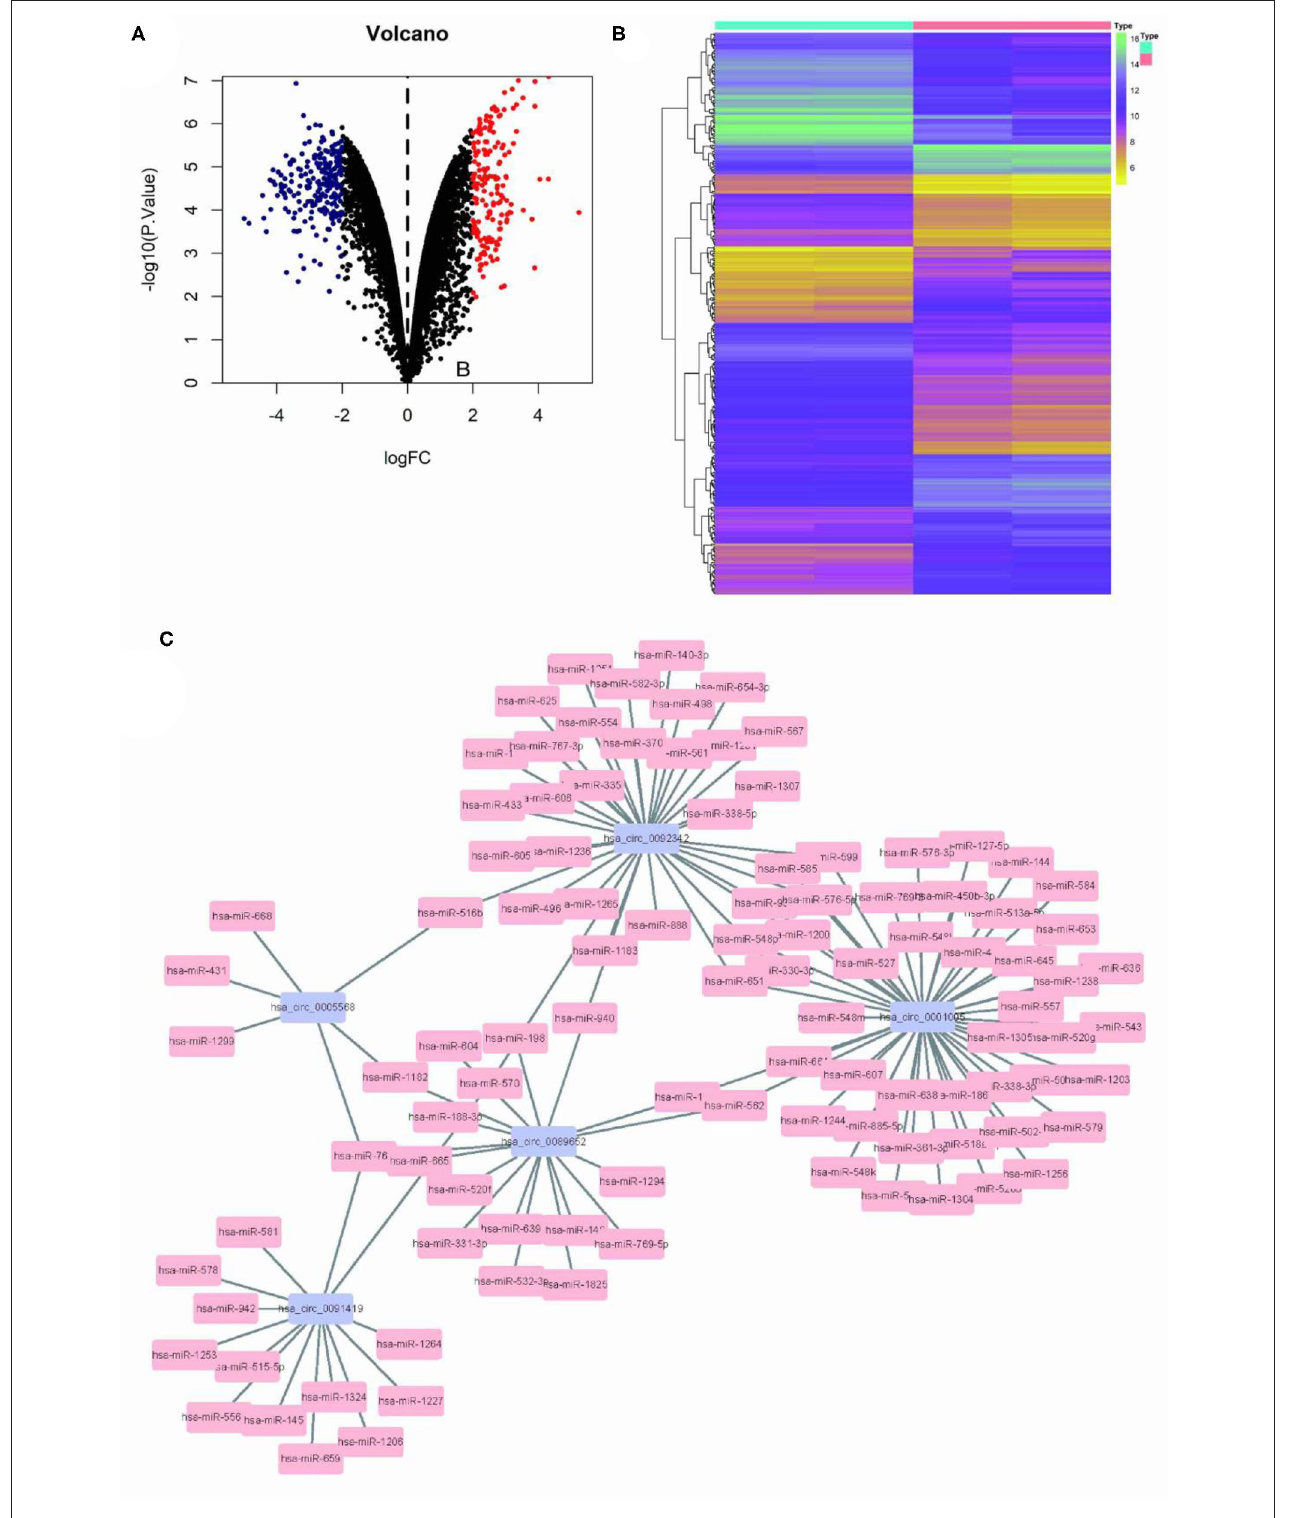
FIGURE 1 | Differential circRNA screening of GSC11 and U87 cells. (A) The volcano plot of abnormal circRNA expression in GSC11 cells. (B) The heat map of abnormal circRNA expression in GSC11 cells. (C) GSC11-highly expressed circRNA-miRNA regulatory networks (125 circRNA-miRNA pairs).